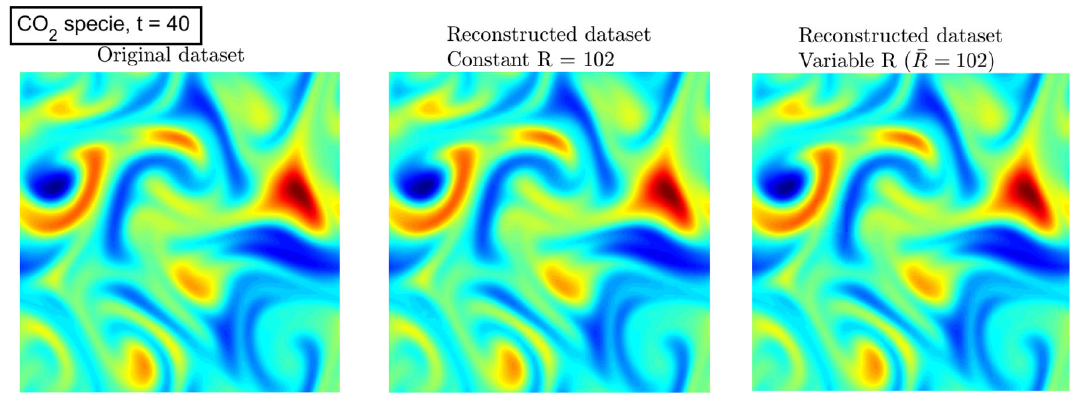
Fig. 11 Plots showing ( left ) the original carbon dioxide CO 2 field; the field is represented on 1600 (cid:6) 1600 regular grid distributed on 10 (cid:6) 10 processes, ( middle ) the reconstructed version using a constant compression ratio R throughout its processes and ( right ) the